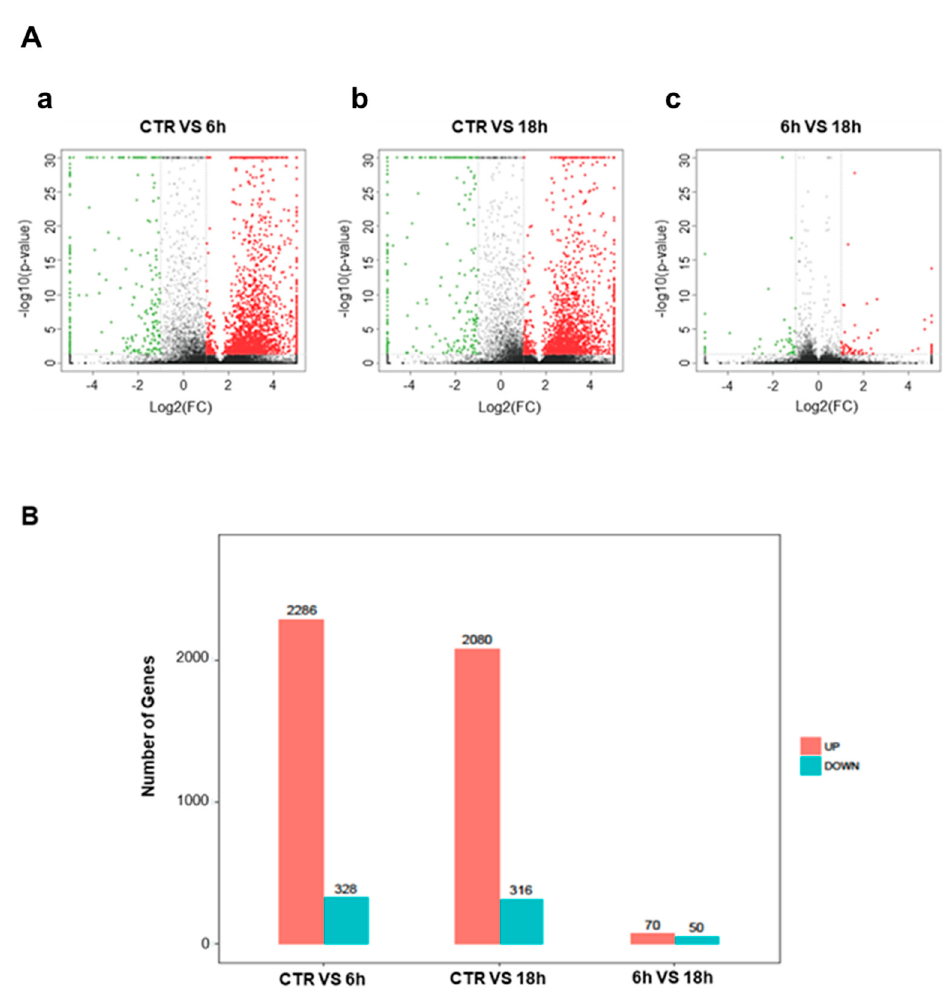
Figure 6 . Differentially expressed genes. ( A ) Volcanic map of differential genes. The DEGs set after 6 h and 18 h of Artemisia–AgNPs treatment. Red dots indicate up-regulated genes, green dots represent down-regulated genes, and black dots indicate genes with no significant difference. (|logFC| ≥ 2 and p value < 0.05). a: CTR vs 6 h; b: CTR vs 18 h; c: 6 h vs. 18 h. ( B ) Histogram of differential genes. The DEGs set disturbed by Artemisia–AgNPs treatment (|logFC| ≥ 2 and p value < 0.05).